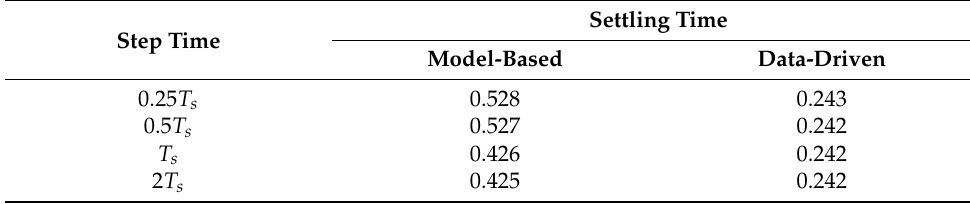
Figure 6. Comparison of both control approaches during voltage reference changes. Table 1. Controller performance using different time